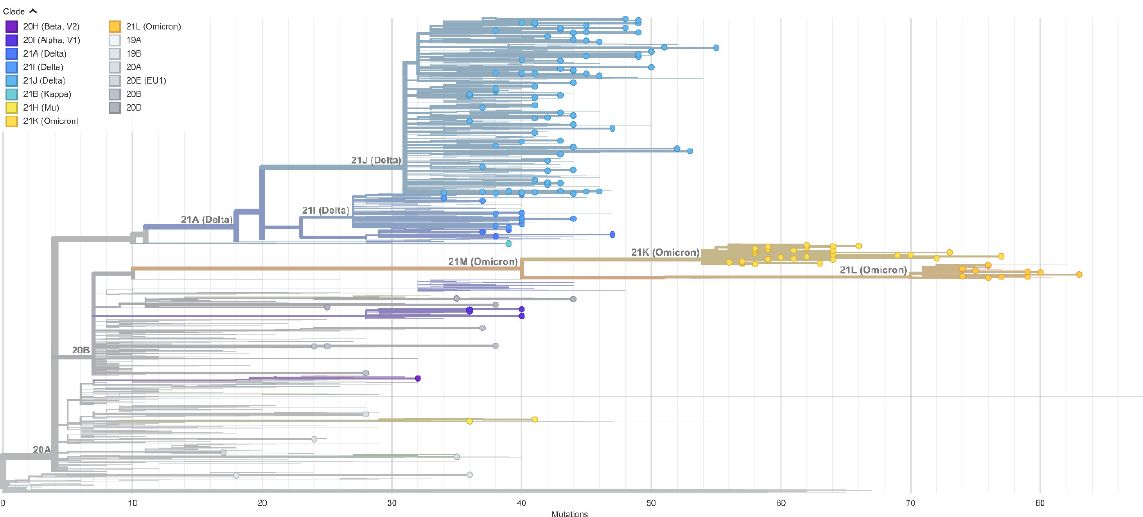
Figure 3. Evolutionary relationships of SARS-CoV-2 samples detected in SR. Altogether 165 different Pango lineages were detected in the evaluated dataset. Individual points in figure represents one lineage detected and deposited in GISAID database on the backbone of global evolutionary tree of SARS-CoV-2 virus.